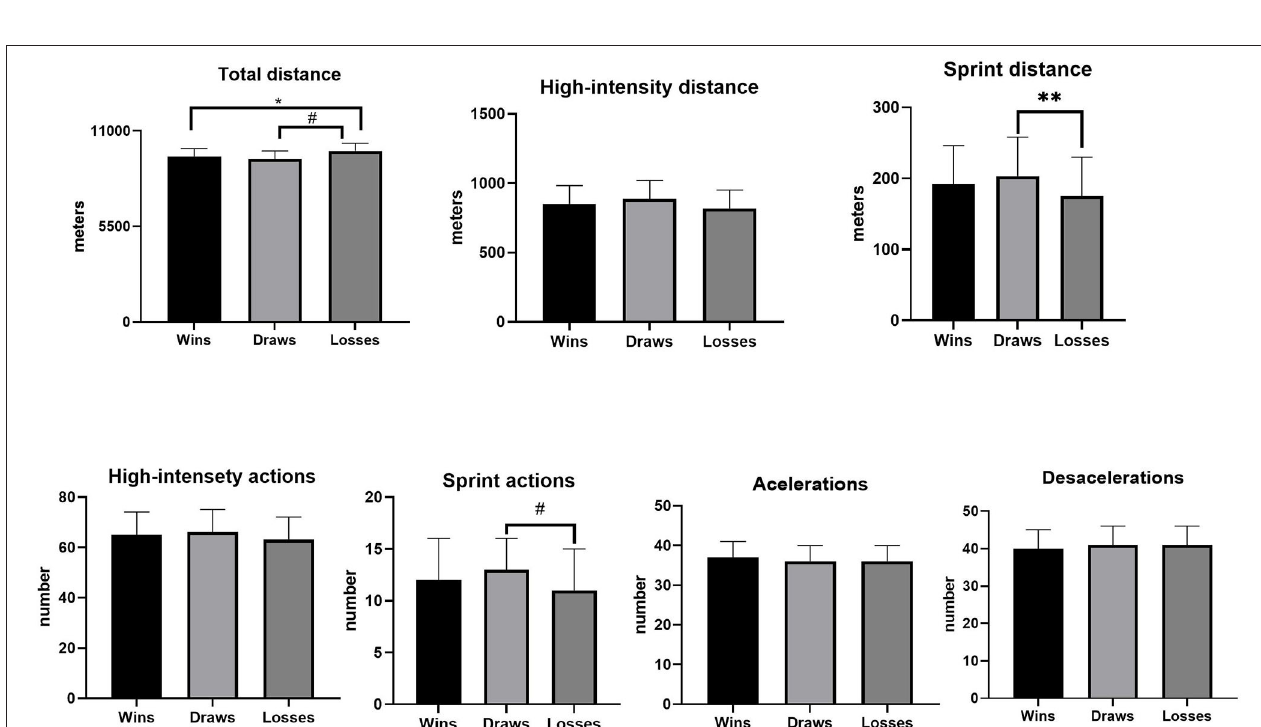
Frontiers in Sports and Active Living |